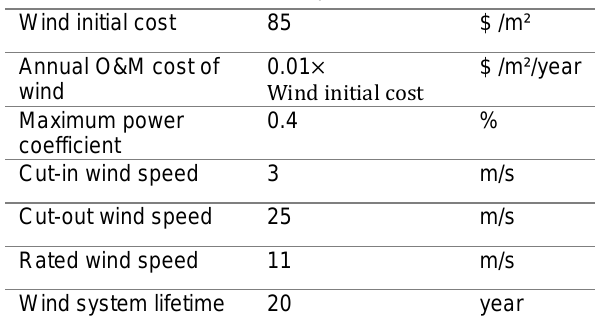
Table 3 . Wind parameters